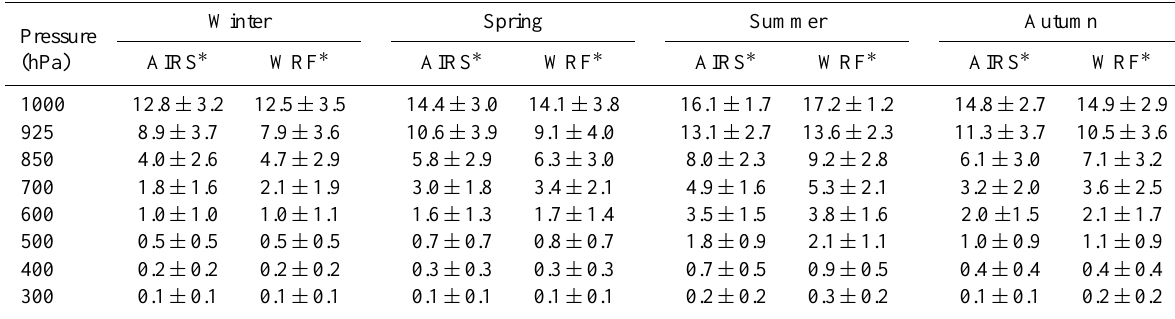
Table 4. Same as Table 3 but for AIRS water vapor (gkg − 1 )